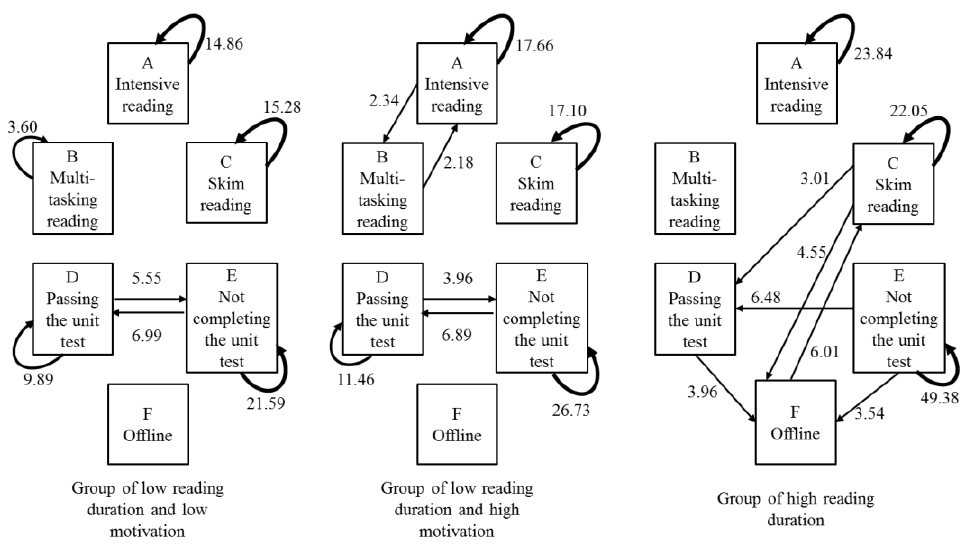
Figure 5. Diagram of sequential behavioral patterns in online reading of all three